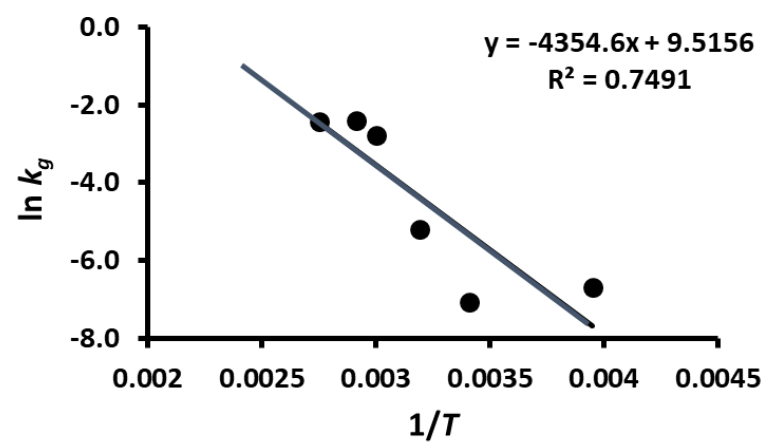
Figure 8. Peak time as a function of storage temperature (line is a trend guide).